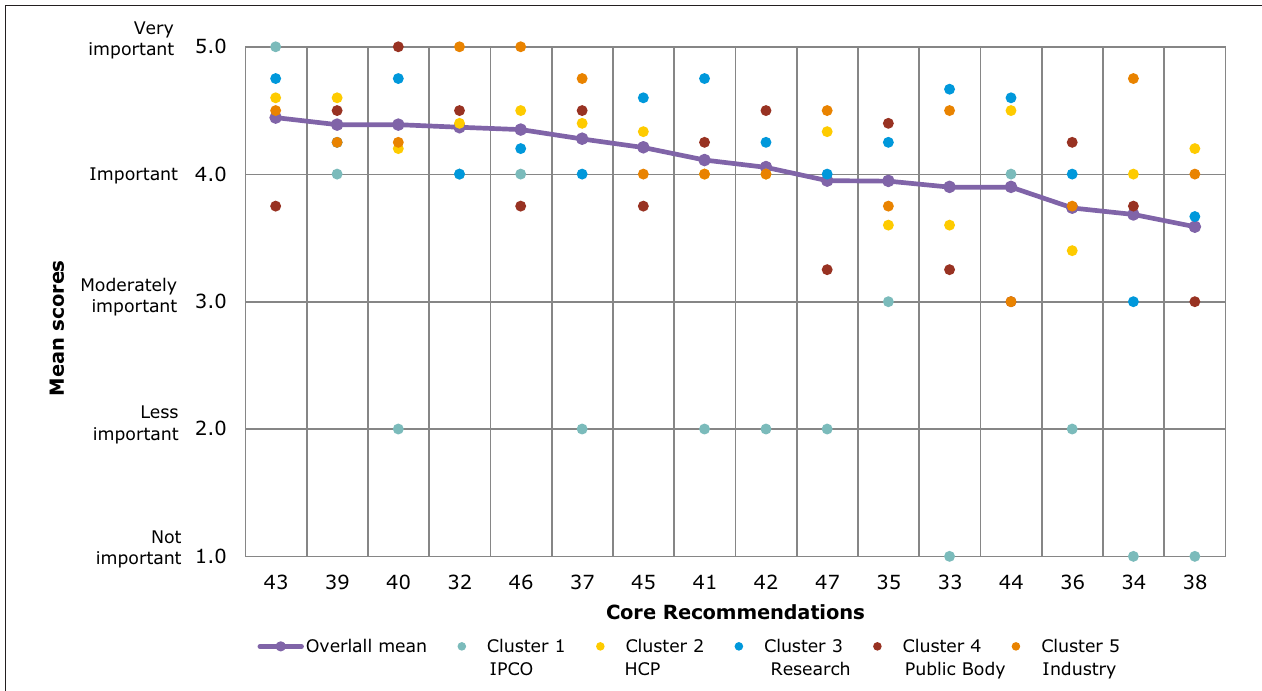
FIGURE 6 | Overall comparison of all Core Recommendations by mean score across stakeholder clusters (question 7, Veterinary). Overall means were calculated based on the individual scores given by participants who rated each Core Recommendation on a scale from 1 to 5: (1) not important; (2) less important; (3)